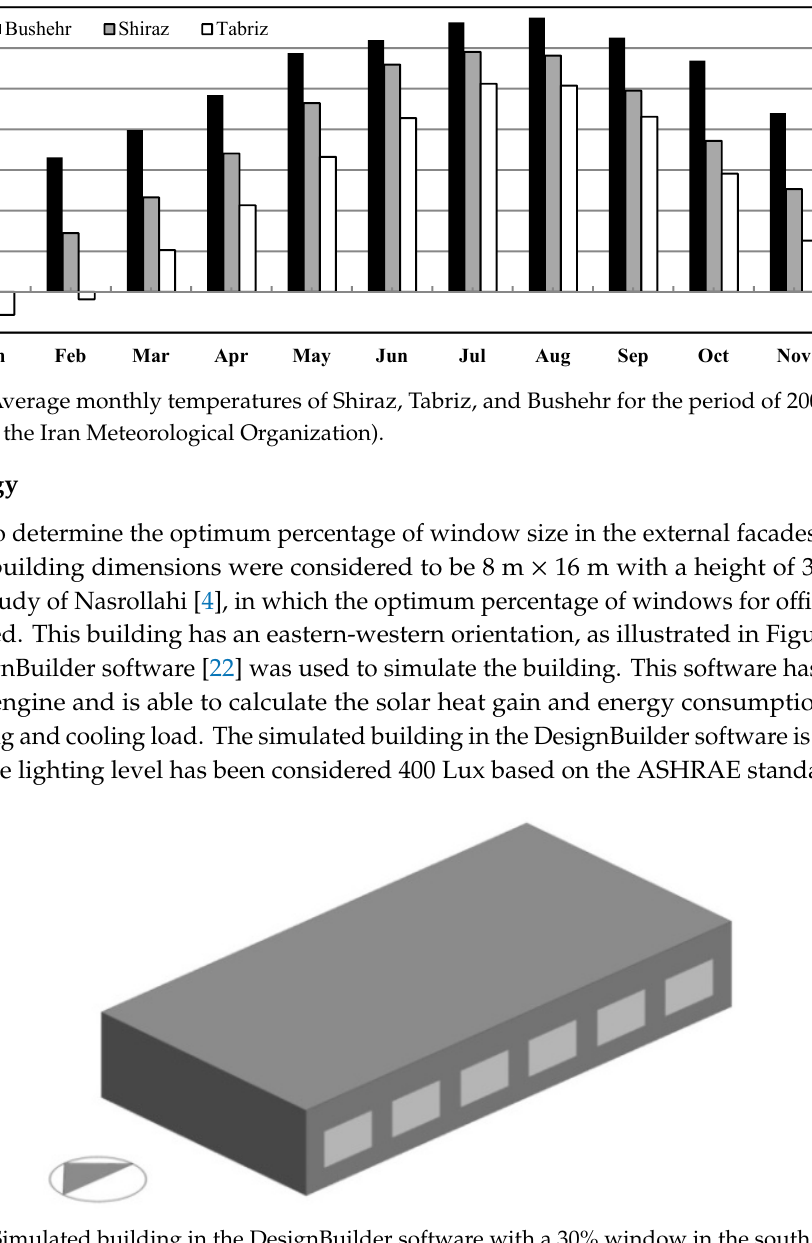
Figure 3. Simulated building in the DesignBuilder software with a 30% window in the south façade.